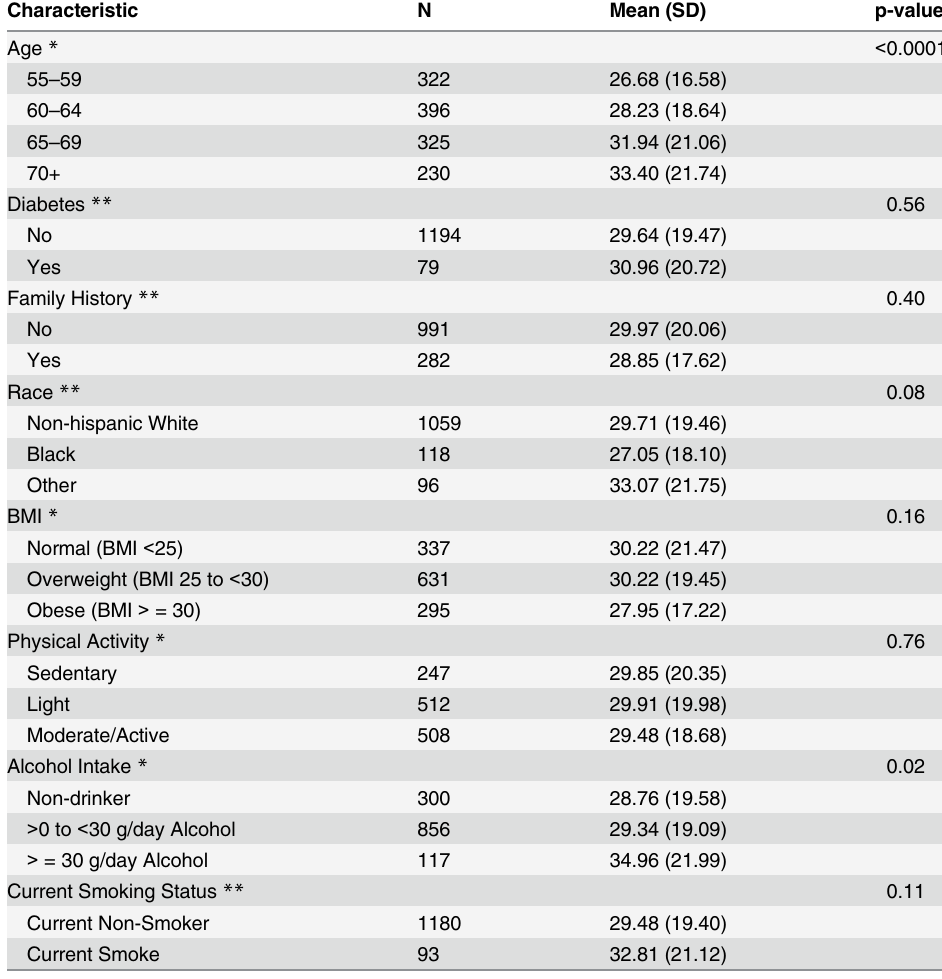
Table 2. Mean finasteride levels (ng/mL) stratified by categories of demographic measures among treatment-compliant men in the Prostate Cancer Prevention Trial finasteride arm.